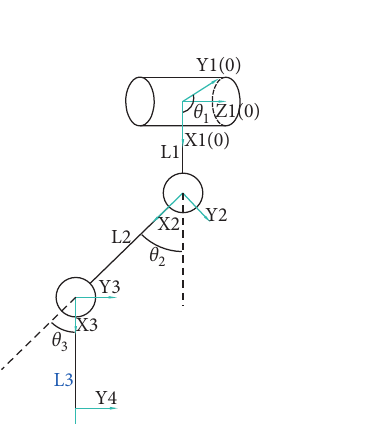
Figure 3: Simplified quadruped robot model.